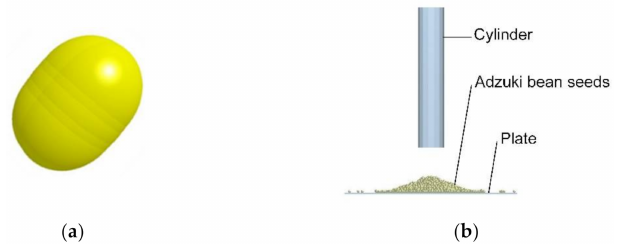
Figure 7. AOR simulation test. ( a ) ABS model; ( b ) AOR measurement